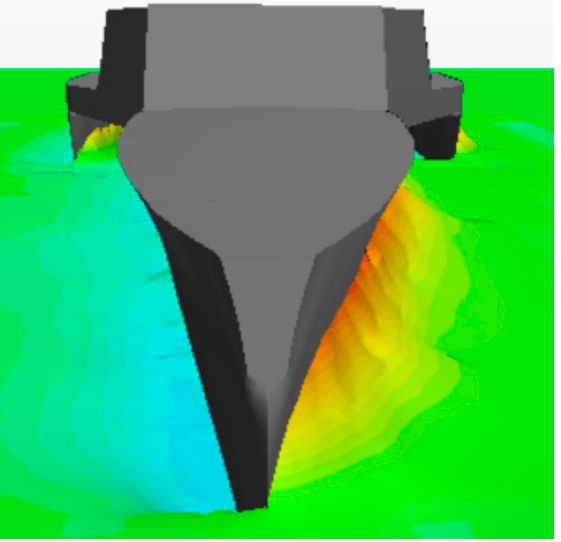
Figure 13. Liquid level difference between the left and right-side hulls of the trimaran in oblique waves.